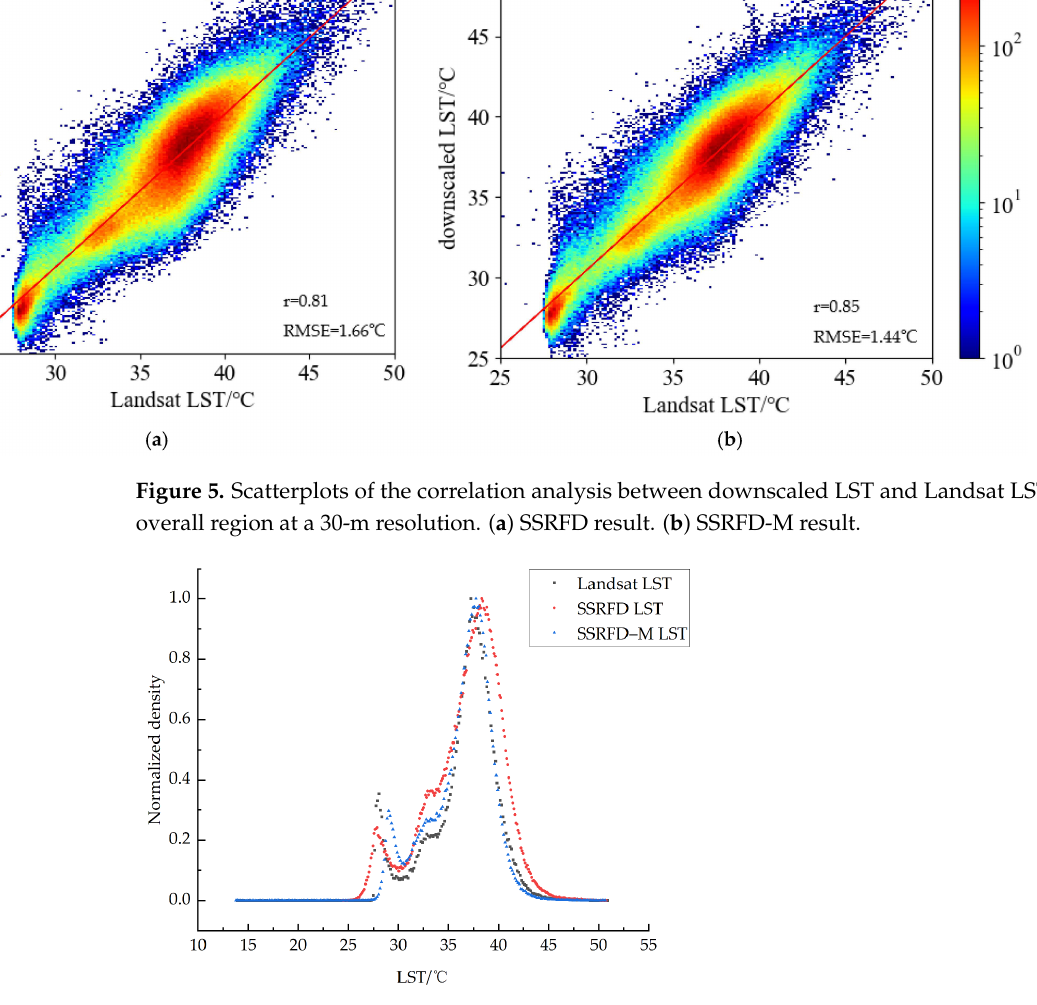
Figure 6. Histogram of downscaled LST and Landsat LST at a 30-m resolution (black cubes refer to Landsat LST, red circles refer to the SSRFD results and blue triangles refer to the SSRFD-M results).